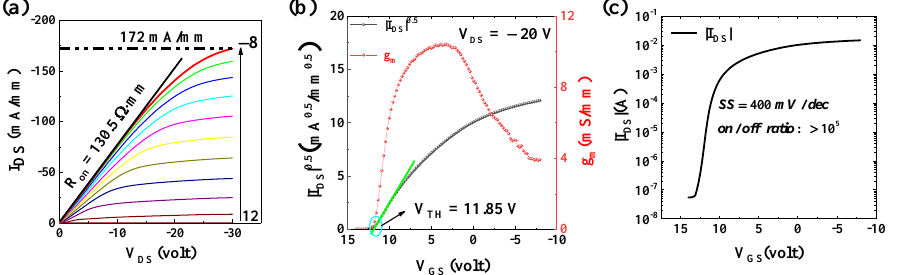
Figure 3. ( a ) Output characteristics of MOSFET; ( b ) transfer curve ( c ) ( − I DS )-V GS characteristics on a logarithmic scale.